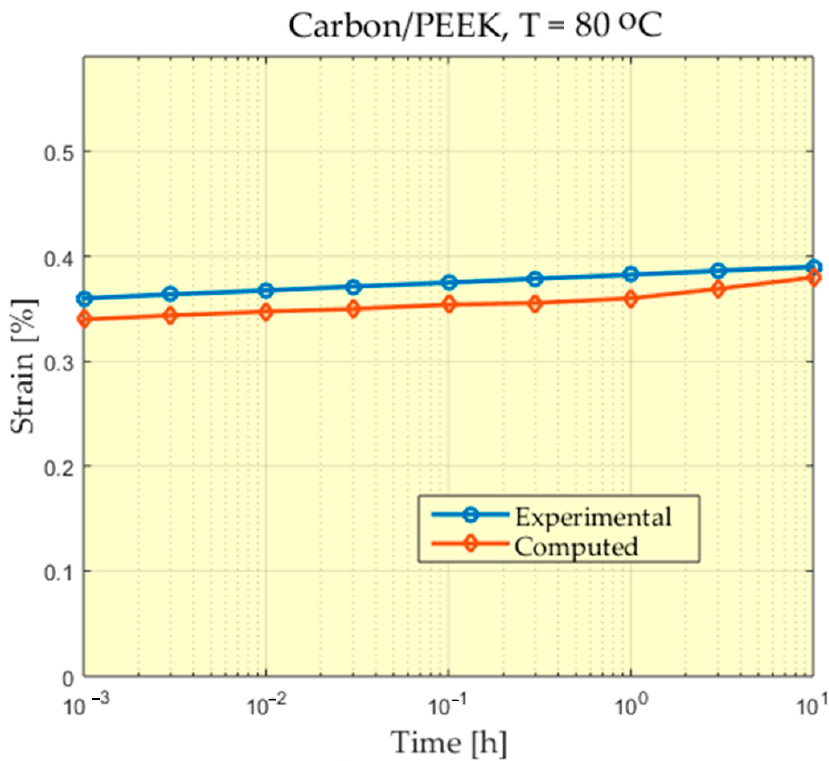
Figure 6. Comparison between experimental and theoretical prediction of creep strain for Car- bon/PEEK subjected to 26 MPa at 80 ◦